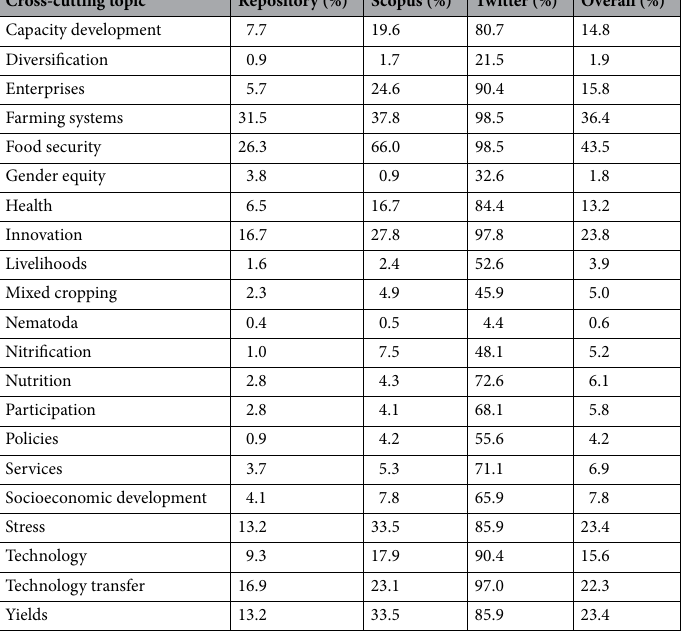
Table 1. Distribution of cross-cutting topics identified in the datasets.